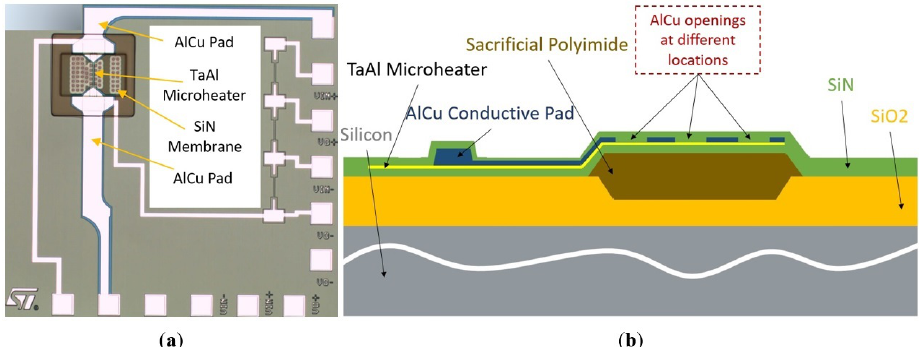
Figure 2. Structure of the SMO gas sensor. ( a ) Top view of the initial D02 design. ( b ) Cross-section of the novel composite heater design with the AlCu openings. To form the gas sensor membrane, the sacrificial polyimide was etched as the last step in the fabrication sequence using selective plasma etching in order to achieve low power consumption and good thermal isolation.